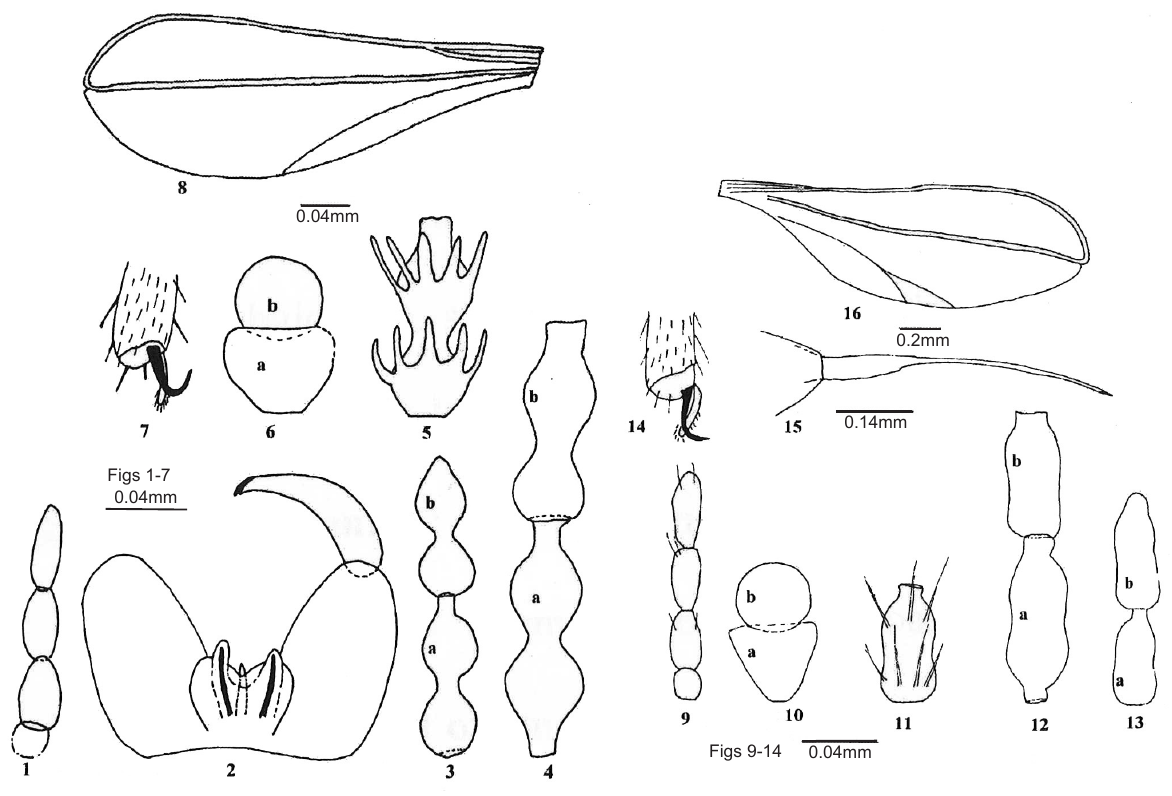
wing margin at its apex and interrupting costa at its union; vein Cu simple. Legs: brown, densely hairy, metatarsus (19) little longer than terminal tarsal segment (17), second tarsal segment (66) longest of all, fourth (17) shorter than the third. Claw (Fig. 7) (11) simple on all legs, sickle shaped, empodium (8) 0.72 the length of claw. Genitalia (Fig. 2) light brown, basal clasp segment (28:15) oval, without lobe, terminal clasp segment (18:5) broad basally and narrow beyond middle, ending with a tooth apically; dorsal plate (13:11) deeply bilobed, lobes oval, subdorsal plate (10:13) shallowly bilobed, shorter and broader than the dorsal plate, lobes rounded apically, with a pair of unsclerotised harpes, the later shorter than the dorsal plate; aedeagus (10) short, tip pointed, shorter than both the plates. Female Body: 1.60mm long. Head: Eyes confluent above. Trophi normal. Palpus (Fig. 9) quadriarticulate, moderately hairy, and sparsely setose; first segment (5:4) subglobose, second segment (9:6) subcylindrical, broad basally; third segment (9:5) cylindrical, shorter and thinner than the second, fourth segment (11:4) longest of all,